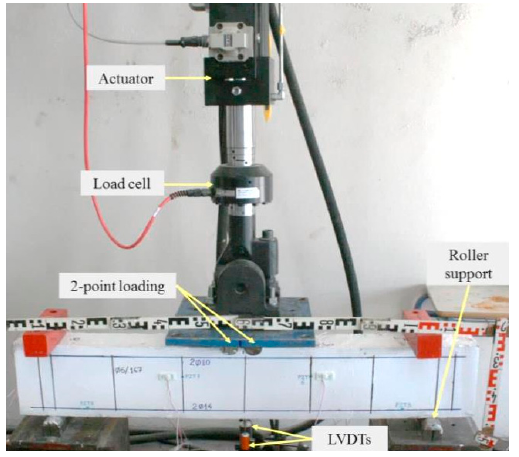
Figure 2. Experimental setup.